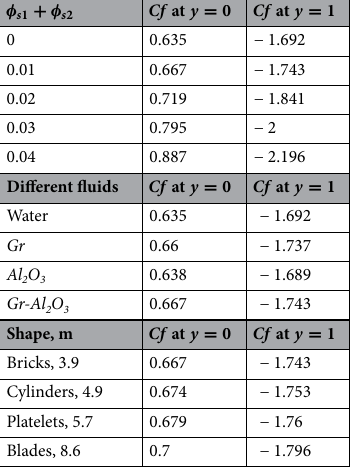
Table 3. The variation of skin fraction on both